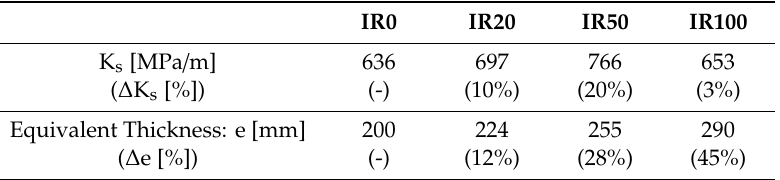
Table 7. Results for the maximum pressure